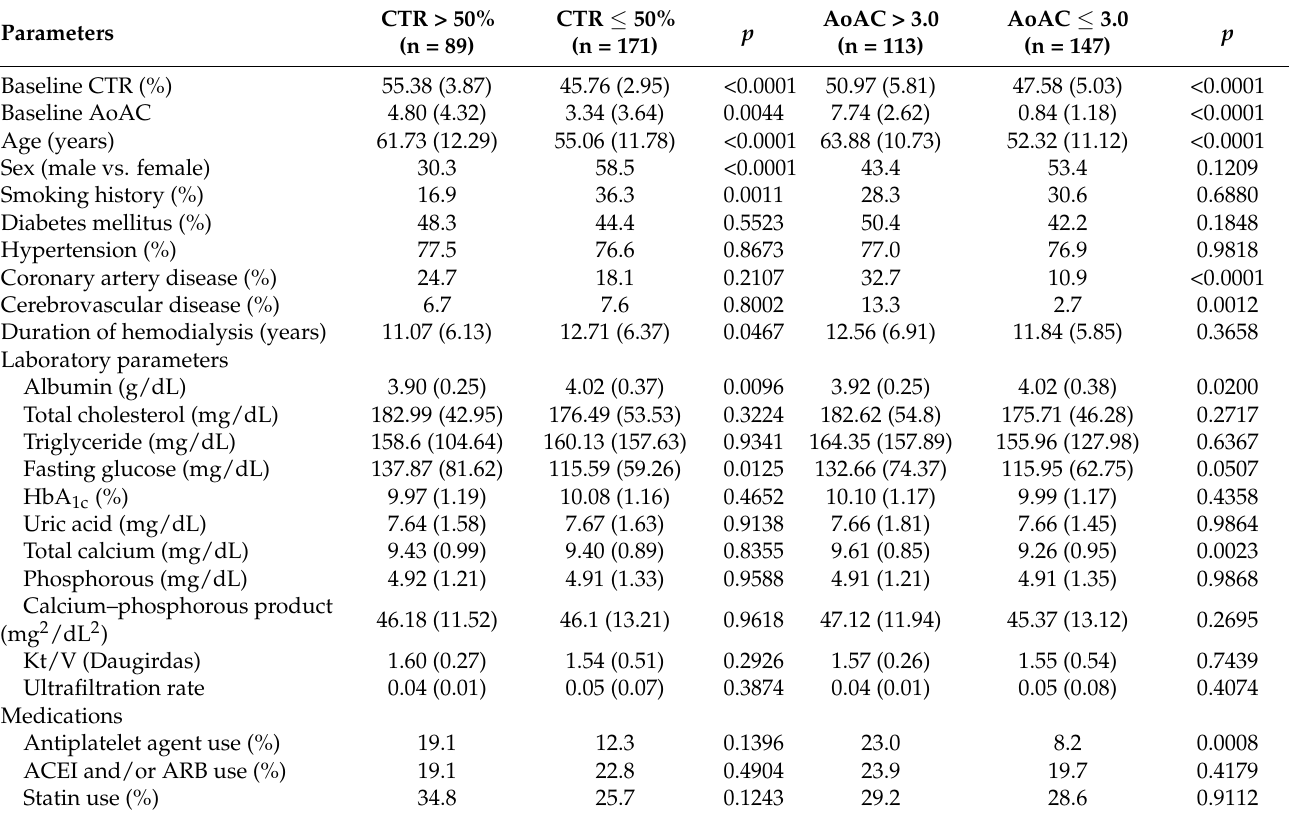
Table 1. Comparison of baseline characteristics between patients with CTR > 50 or ≤ 50 and AoAC >3 or ≤